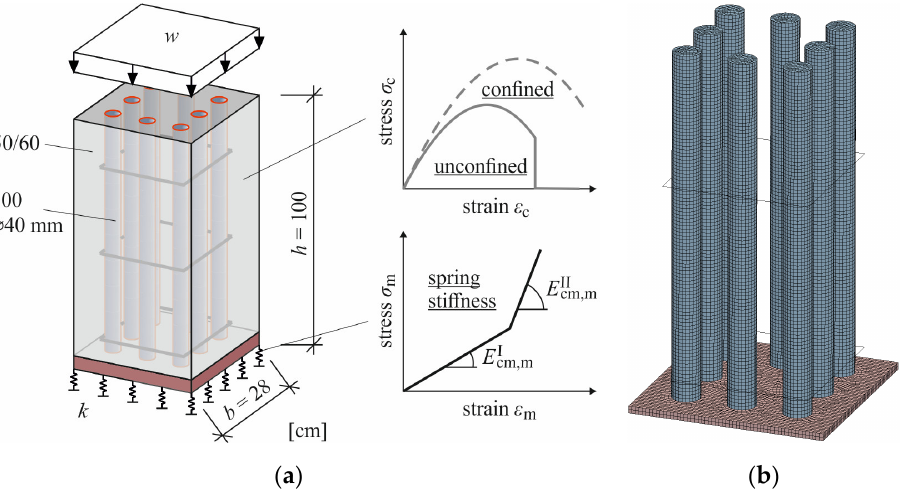
Figure 17. FE model of the butt joint in a reinforced concrete column: ( a ) entire model with specific model properties; ( b ) detail with hidden concrete elements.